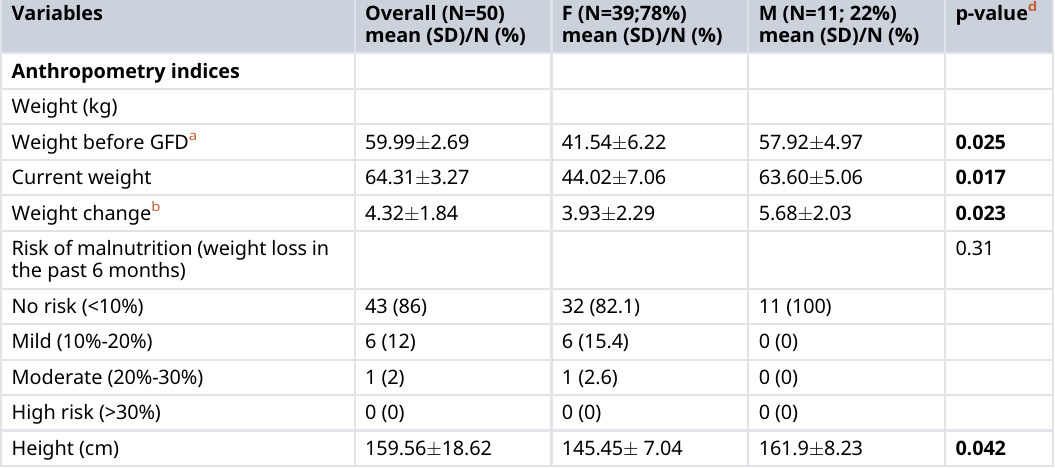
Table 2. Anthropometry measures, medical and lifestyle characteristics of the study population, overall and by gender. CD: celiac disease; BMI: body mass index.